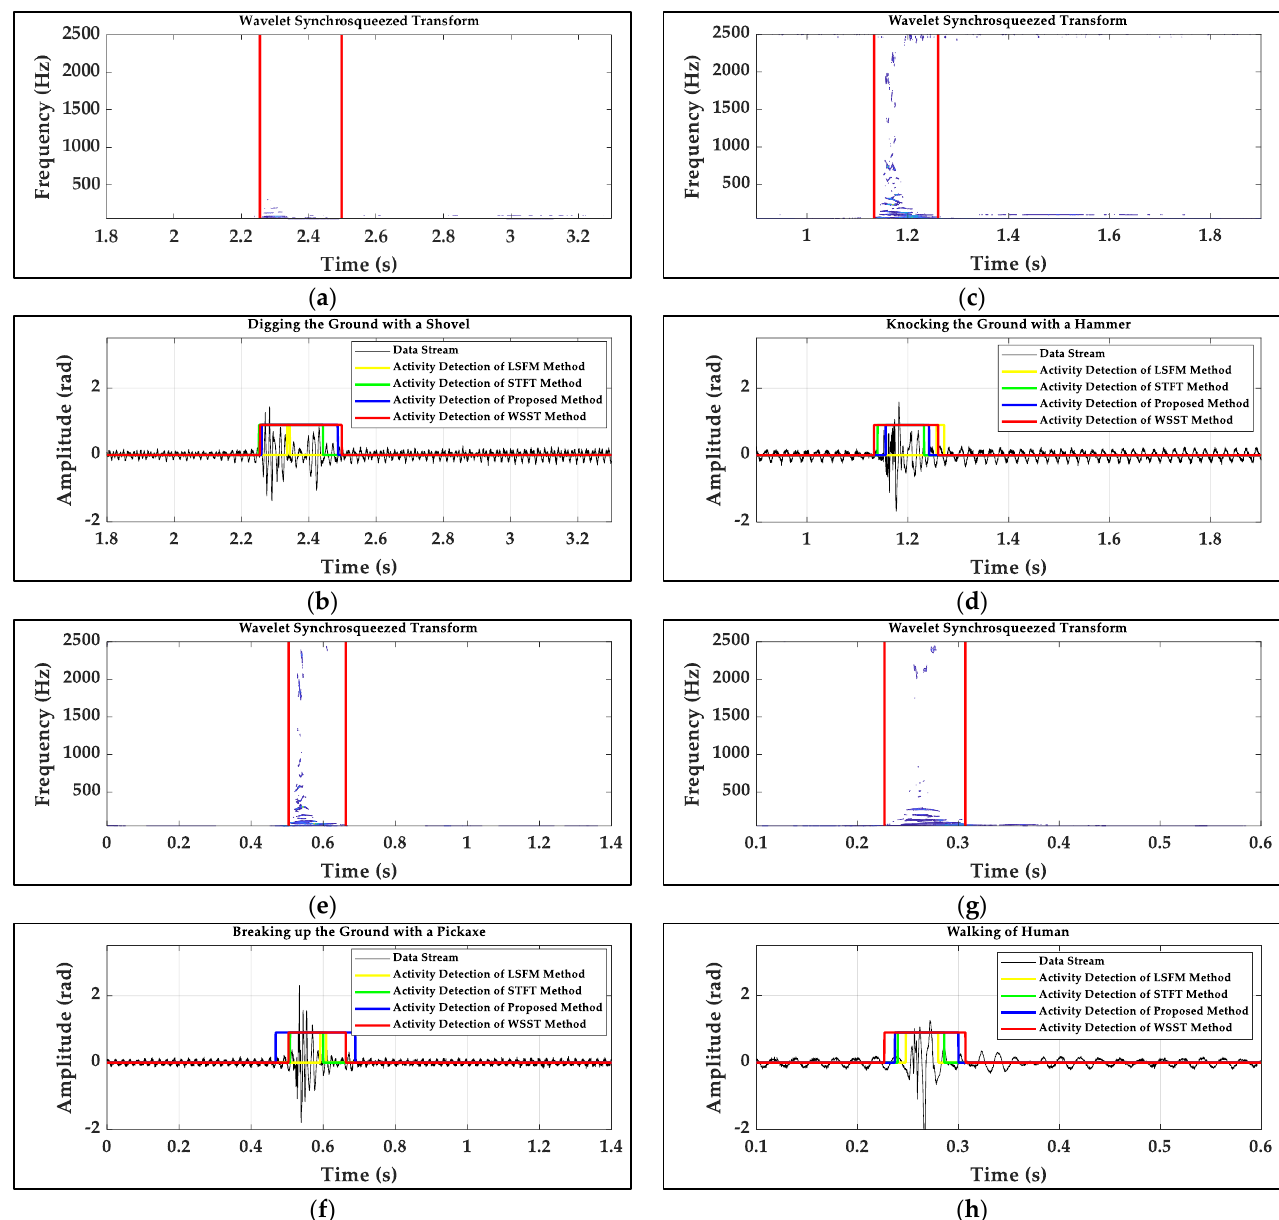
Figure 9. The manual determination of the onsets and the endpoints of four kinds of actual signals with the wavelet synchrosqueezed transform method and the comparation of detection onset and endpoint errors obtained by proposed method, the LSFM method and the STFT method: ( a , b ) digging the ground with a shovel; ( c , d ) knocking the ground with a hammer; ( e , f ) breaking up the ground with a pickaxe; ( g , h ) walking of human.